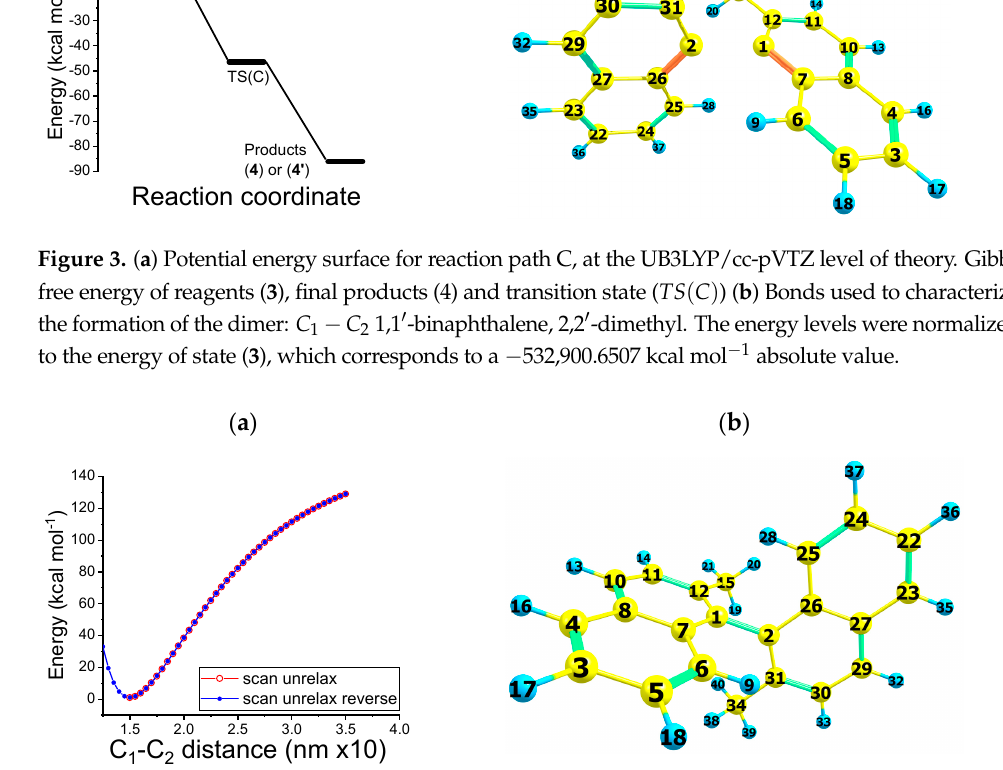
Figure 3. ( a ) Potential energy surface for reaction path C, at the UB3LYP/cc-pVTZ level of theory. Gibbs free energy of reagents ( 3 ), final products ( 𝟒 ) and transition state ( 𝑇𝑆 ( 𝐶 ) ) ( b ) Bonds used to characterize the formation of the dimer: 𝐶 (cid:2869) − 𝐶 (cid:2870) 1,1 ′ -binaphthalene, 2,2 ′ -dimethyl. The energy levels were normalized to the energy of state ( 3 ), which corresponds to a − 532,900.6507 kcal mol − 1 absolute value.